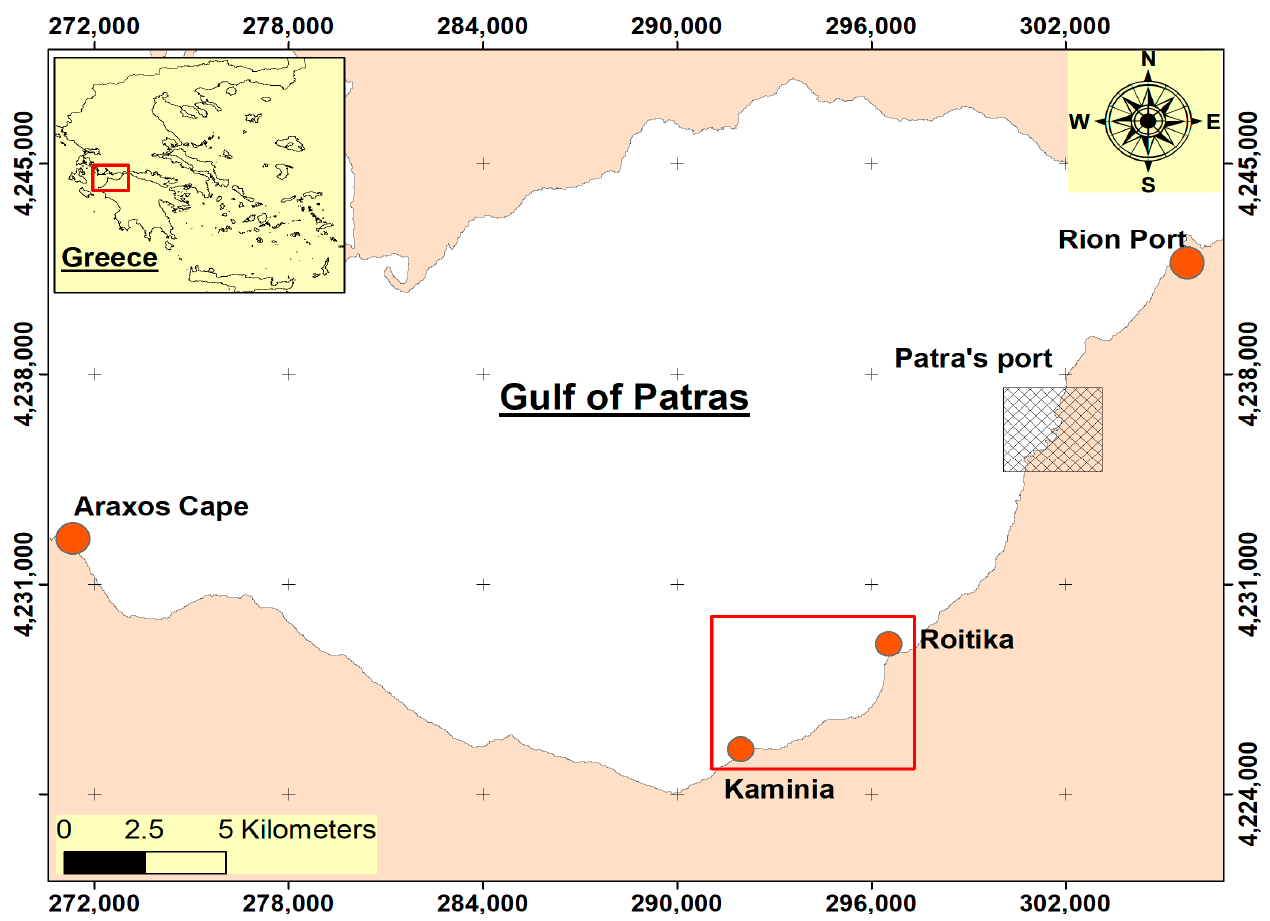
Figure 4. Study area (Araxos Cape–Rion Port) covered by the remote sensing datasets and test site (red frame area of Kaminia and Roitika villages) using GNSS measurements.